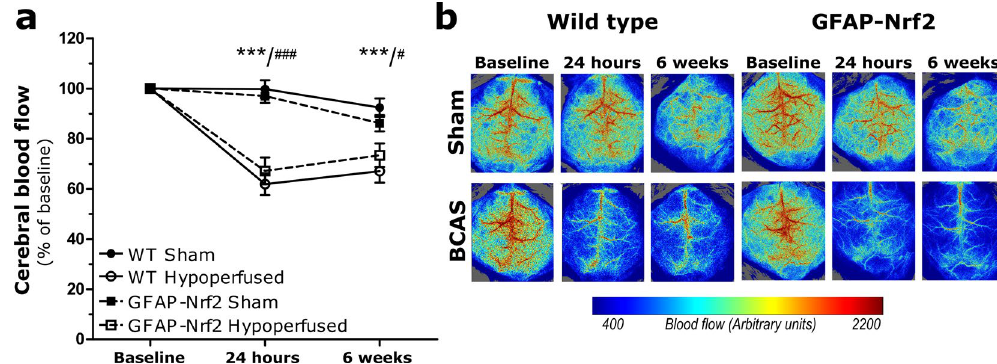
Figure 1. Resting cortical cerebral blood flow (CBF) is significantly reduced following bilateral carotid artery stenosis in wild type and GFAP-Nrf2 mice. ( a ) Resting CBF was significantly reduced by 30–40% from baseline 24 hours after bilateral carotid artery stenosis (BCAS) surgery and remained significantly reduced at 6 weeks for both groups. Effect of time F (2,64) = 57.02, p < 0.0001, effect of surgery F (1,32) = 55.20, p < 0.0001, no significant effect of genotype. ( b ) Representative images of laser speckle flowmetry at baseline and at 24 hr and 6weeks post-surgery. Repeated measures ANOVA with Bonferroni adjustment for post hoc analysis. Mean ± SEM. WT/